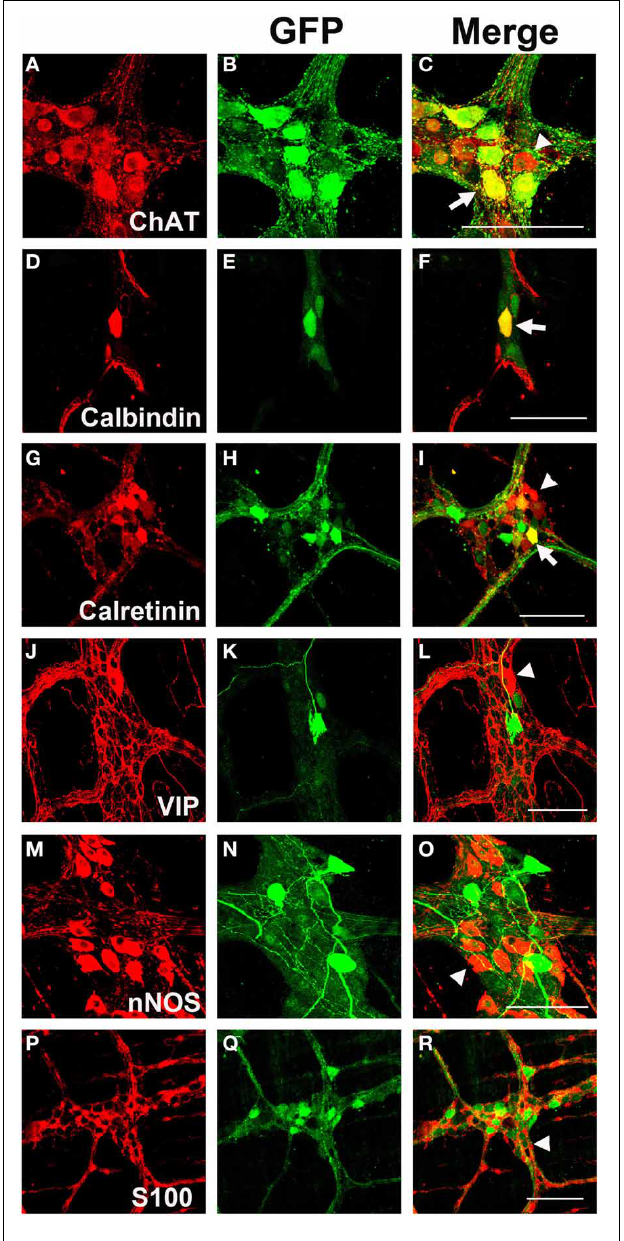
FIGURE 4 | Chemical coding of transduced myenteric cells in the colon after systemic scAAV9-CB-GFP injection. GFP expression (B,E,H,K,N,Q) was detected in choline acetyltransferase (ChAT, A,C ) positive, calbindin positive (D,F) , and calretinin positive (G,I) myenteric neurons and some intraganglioninc fibers. ChAT staining is indicative of excitatory motor neurons and ascending and descending projecting interneurons. Calbindin and calretinin calcium binding proteins are indicative of excitatory motor neurons and some classes of interneurons. Transduction was rare or completely absent in vasoactive intestinal peptide (VIP, J,L ) positive or neuronal nitric oxide synthase (nNOS, M,O ) positive cells. VIP and nNOS staining is associated with inhibitory motor neuron and descending interneurons. GFP did not co-localize with S100 positive glial cells (P,R) . Arrows indicate co-expression while arrowheads indicate no GFP expression. Scale bars are 100 μ m.